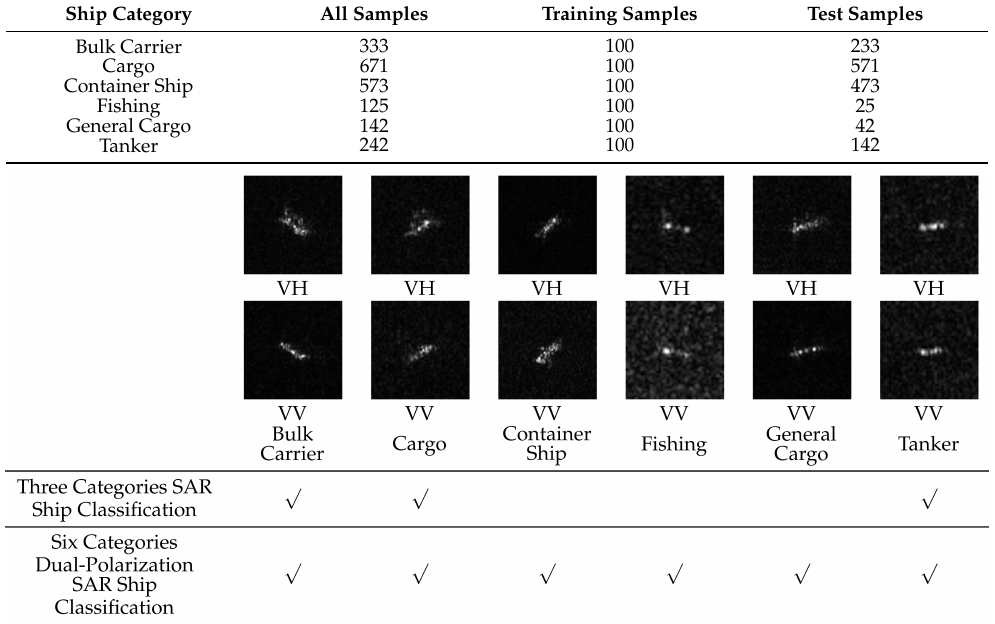
Figure 6. SAR ship samples in